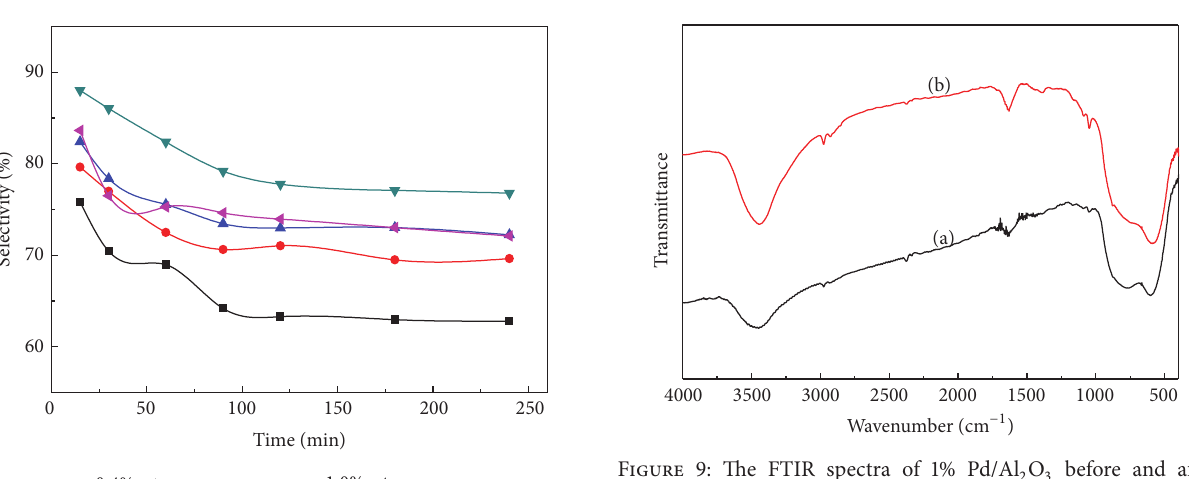
Figure 9: The FTIR spectra of 1% Pd/Al 2 O 3 before and after reaction. (a) 1% Pd/Al 2 O 3 ; (b) 1% Pd/Al 2 O 3 after